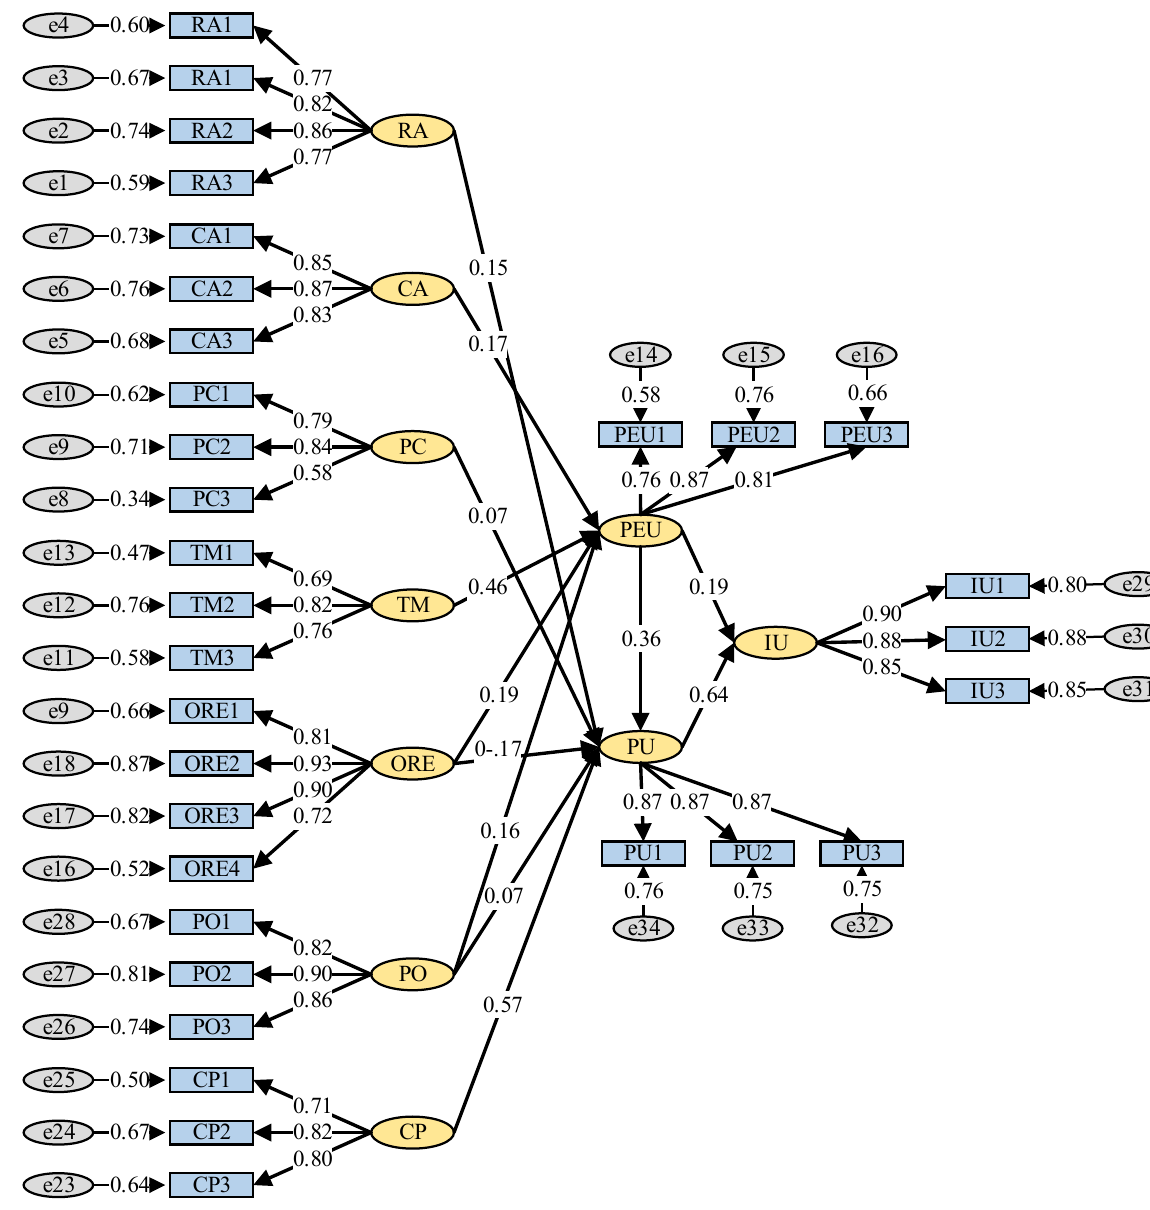
Figure 3. The structural model. Table 6. Hypothesis testing.